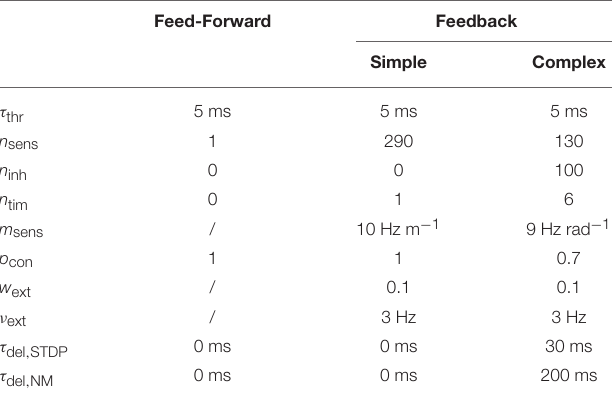
TABLE 1 | Parameters of the neuron models and the structure of the neural network. Feed-Forward Feedback Simple